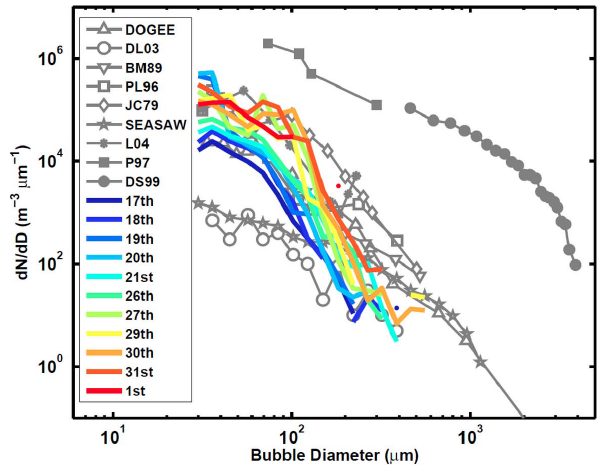
Fig. 13. Mean bubble spectra for several of the days during AS- COS (in color). A number of open ocean (grey open symbols) and surf zone spectra (grey filled symbols) are shown for comparison. The SEASAW ( U = 8ms − 1 ), DL03 ( U = 5ms − 1 ) and the ASCOS data were all measured at a depth of approximately 0.4m using the same optical instrument. Acoustic measurement systems were uti- lized in the open ocean in DOGEE (averaged over a depth of 0–3 m, U = 13ms − 1 ), BM89 (depth 0.25m, U = 12–15ms − 1 ), PL98 (depth 0.5m, U = 12–14ms − 1 ) and JC79 (depth 0.7m, U = 11– 13ms − 1 ), and in the surf zone (L04, P97 and DS99). Figure is adapted from Norris et al. (2011); see discussions therein and in Brooks et al.